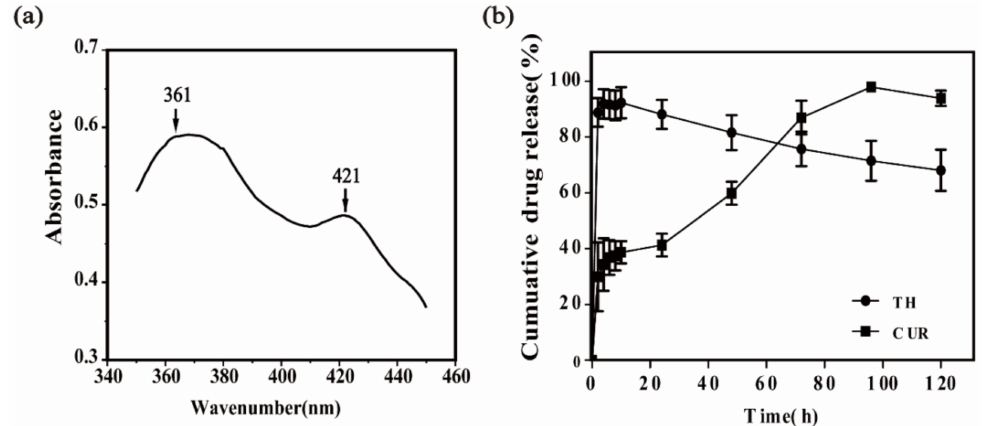
Figure 3. ( a ) Absorbance of CUR and TH at different wavelengths. ( b ) Drug release curves of